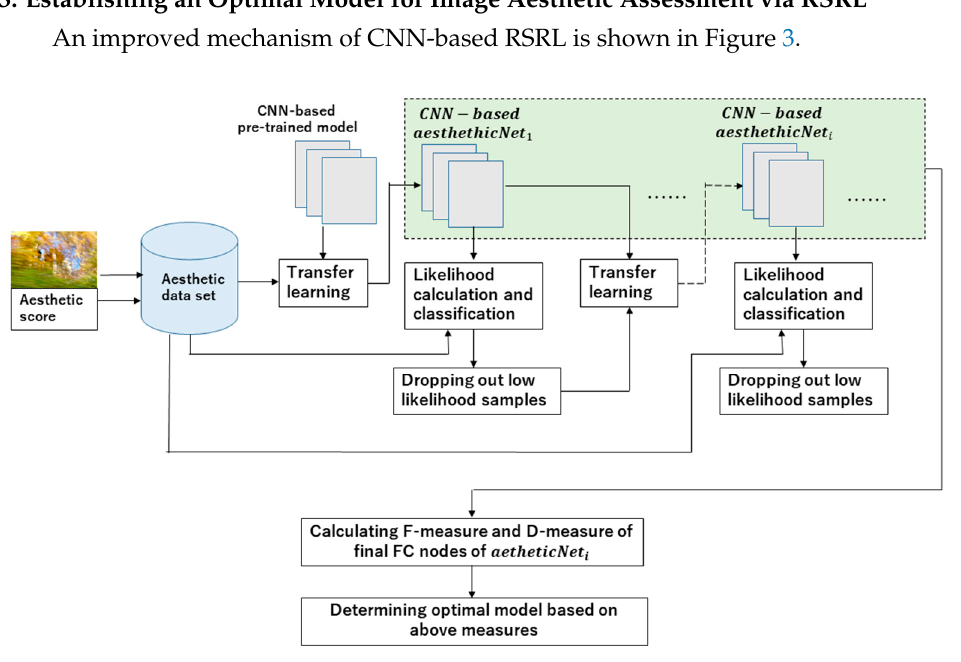
Figure 3. Improved CNN-based Figure 3. improved CNN-based RSRL.